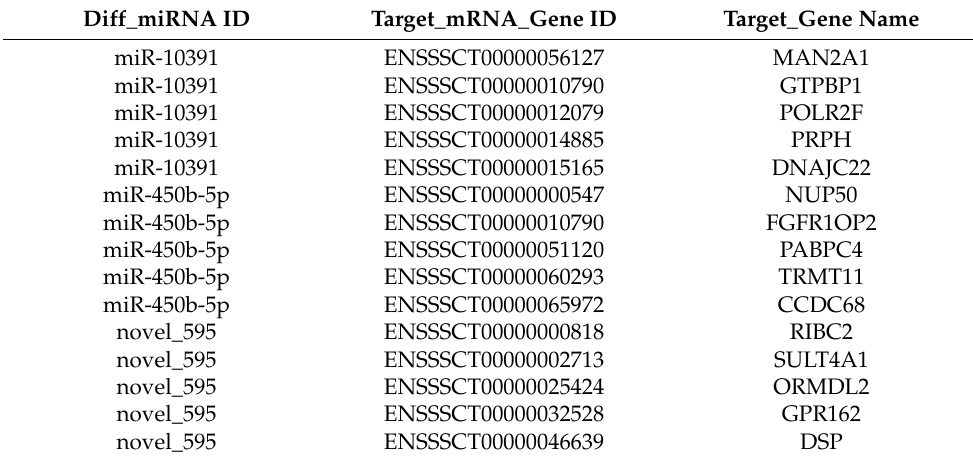
Table 4. Target genes prediction of 3 differential